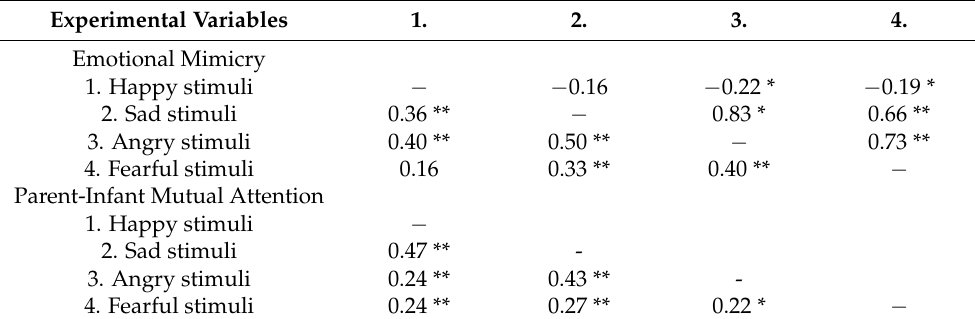
Table 2. Correlations within the experimental constructs of infant and parent emotional mimicry, and parent-infant mutual